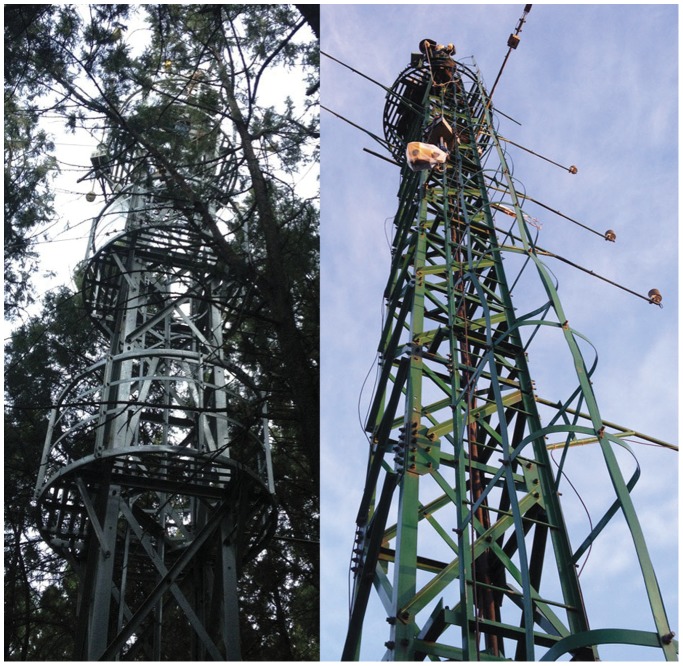
The experiment setup at the study sites.The left panel is the tower in Olympic Forest Park in Beijing and the right panel is the tower in Jiufeng National Forest Park in Beijing.